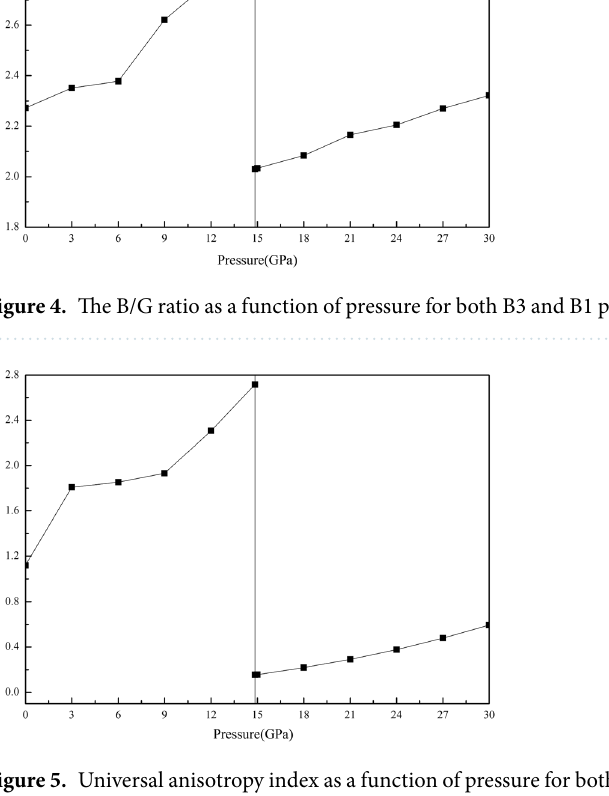
Figure 5. Universal anisotropy index as a function of pressure for both B3 and B1 phases of